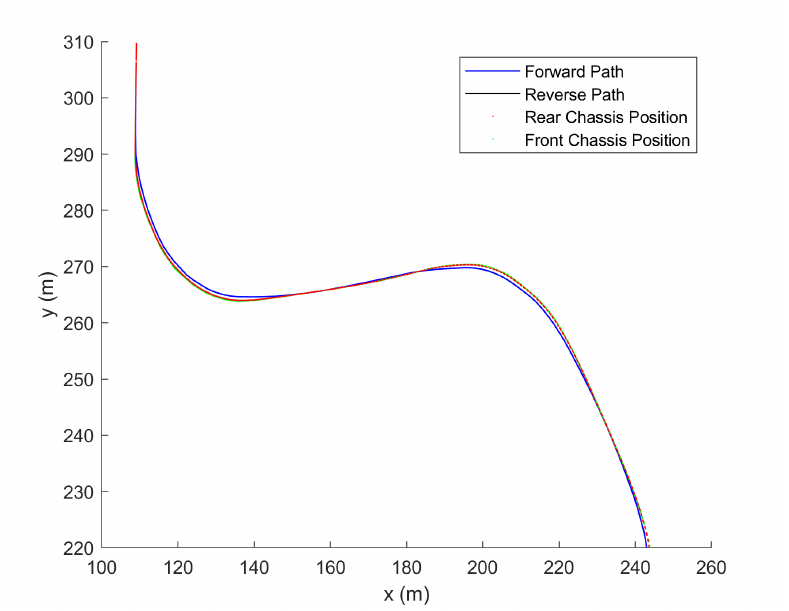
Figure 14. Forward path tracking in A1. Blue line represents the path constructed from the waypoints. The red markers represent the GPS position of the front chassis read from the simulator.